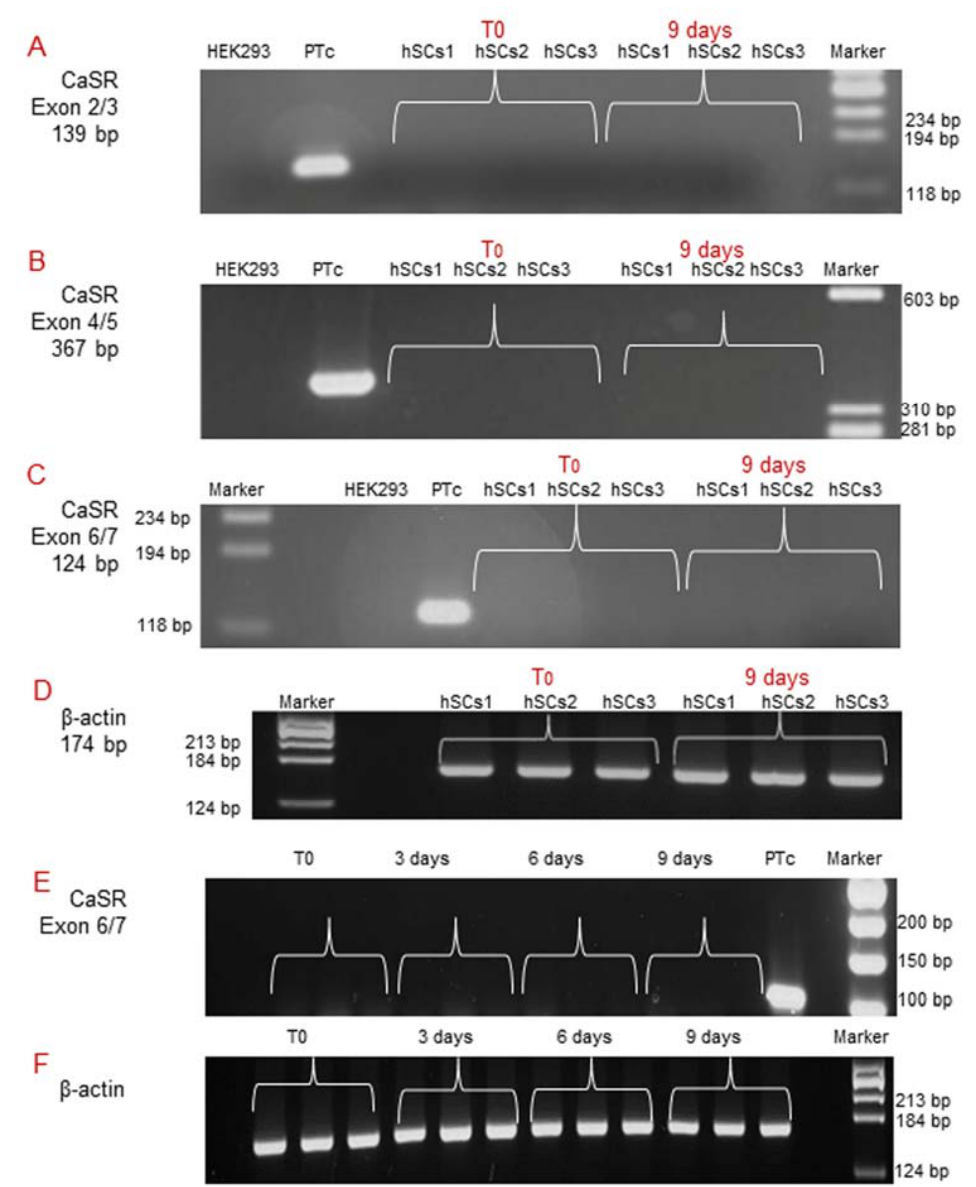
Figure 4. Molecular analysis of CaSR gene expression during in vitro myogenesis of the hSC lines. The analysis showed the absence of the CaSR gene at T 0 and at 9 days of myogenic differentiation of 3 primary hSC lines using different pairs of primers that fall into: ( A ) exons 2/3; ( B ) exons 4/5; ( C ) exons 6/7. The primary cultured human PTcs were used as a positive control and HEK293 cells were used as a negative control. Housekeeping β -actin gene analysis of the assayed samples ( D ). Real-time qPCR analysis of CaSR gene at different time points T 0 , 3, 6, 9 days of myogenesis of the established hSC lines. The analysis showed no detection of expression of CaSR gene in hSC lines. Human primary cultured parathyroid cells (PTcs) were used as positive control ( E ). Negative control: PCR without template cDNA in β -actin gene analysis ( F ). Experiments were carried out in triplicate and are representative of the three established hSC